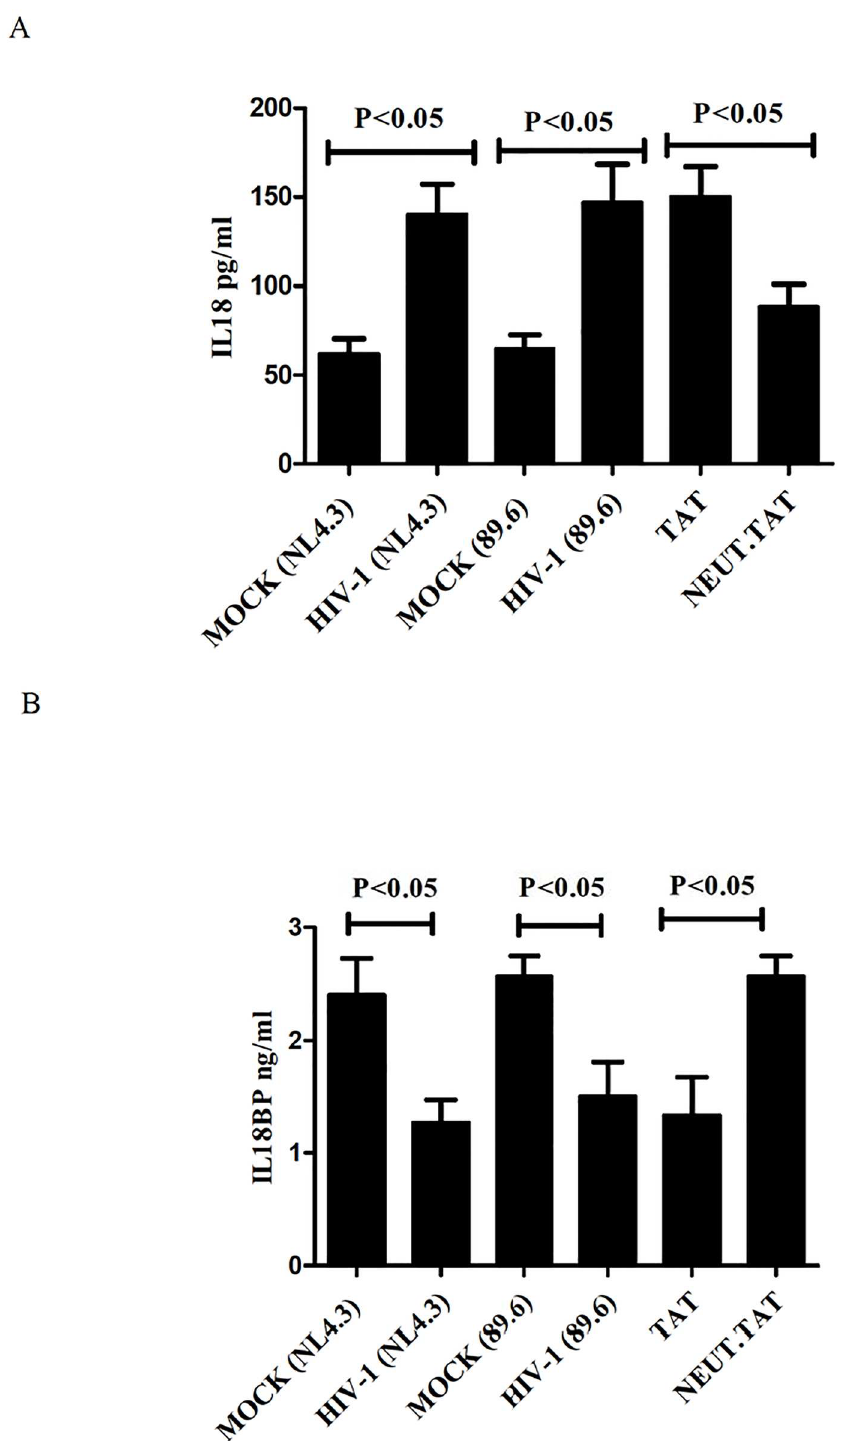
Fig 3. The effects of HIV and Tat treatments on the secretion of IL-18 and IL-18BP from IEC. The panels A and B show mean concentrations of IL-18 and IL-18BP, respectively, in the culture supernatants. The vertical line on each bar denotes standard deviation. The Tat used in these experiments was pre-treated with Tat-neutralizing antibodies (Neut Tat) or with control antibodies (Tat).